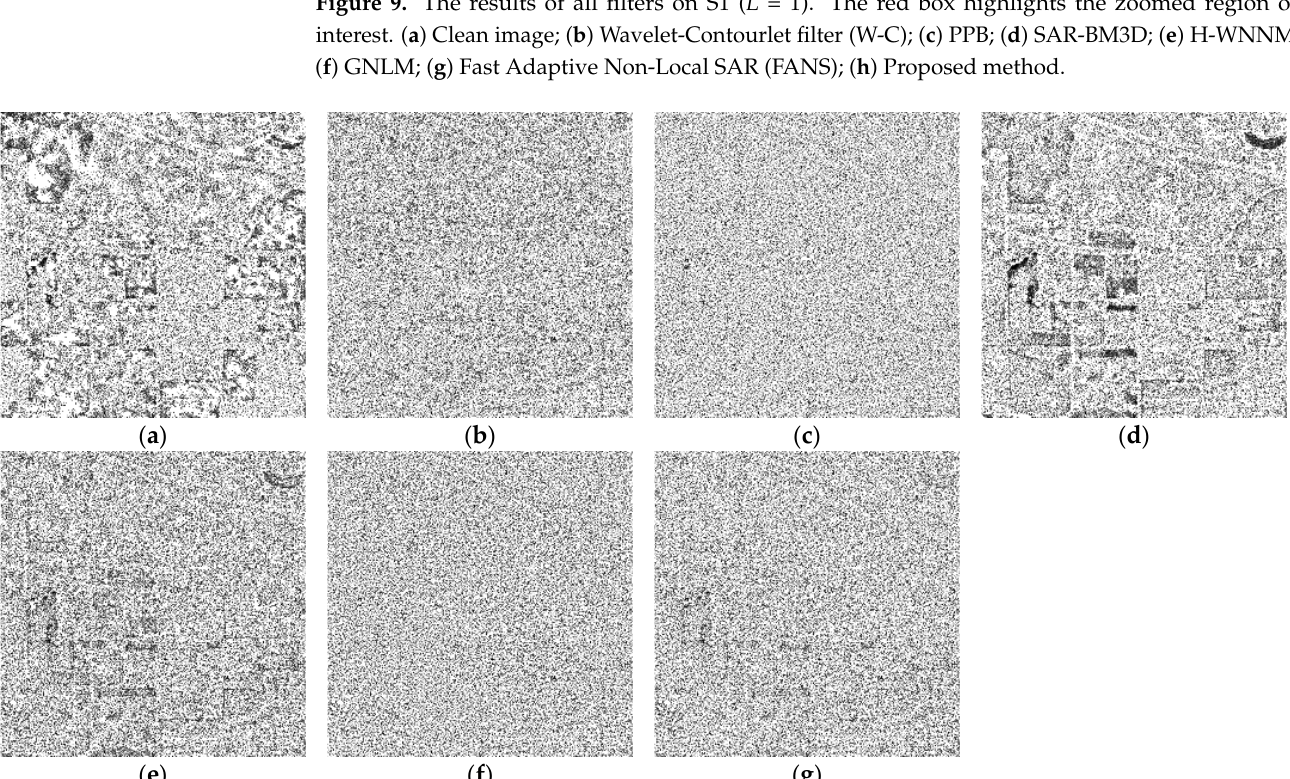
( h ) Figure 11. The results of all filters on S3 ( L = 1). The red box highlights the zoomed region of inter- est. ( a ) Clean image; ( b ) W-C; ( c ) PPB; ( d ) SAR-BM3D; ( e ) H-WNNM; ( f ) GNLM; ( g ) FANS; ( h ) Proposed method. However, when the number of looks is high (i.e., the noise level is low), SAR-BM3D and FANS perform quite well. The main reason is that when the noise level is low, the filtering results of SAR-BM3D and FANS do not introduce excessive residues and arti- facts, respectively. Regarding ENL, GNLM and H-WNNM maintain nearly the highest